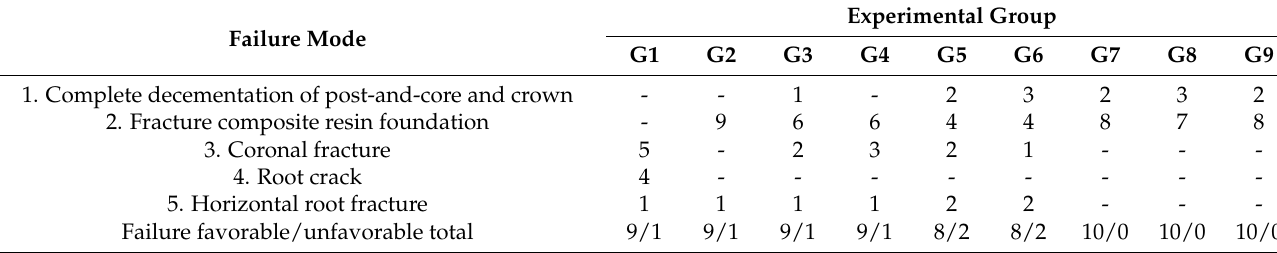
Table 4. Distribution of failure